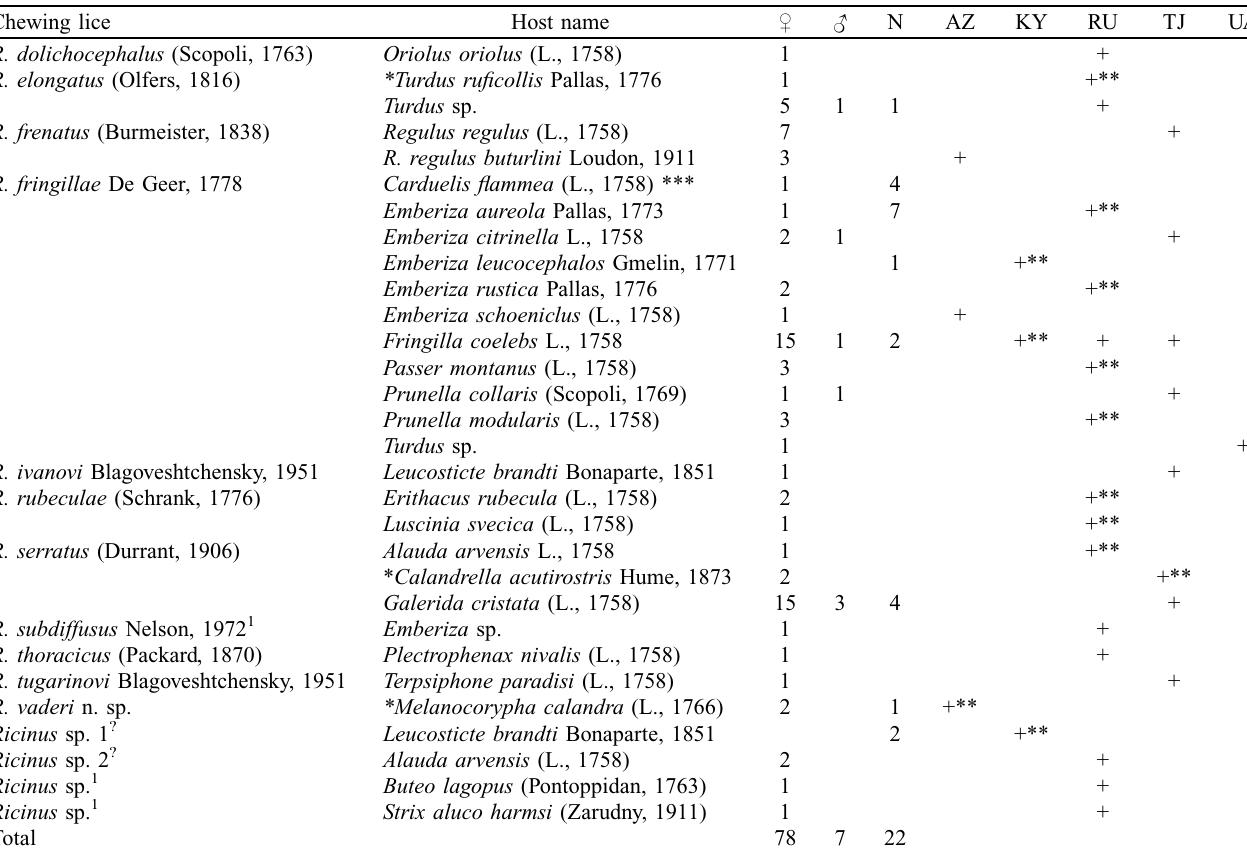
Table 1. A list of chewing lice of the genus Ricinus deposited at the Zoological Institute of the Russian Academy of Sciences, Saint Petersburg,